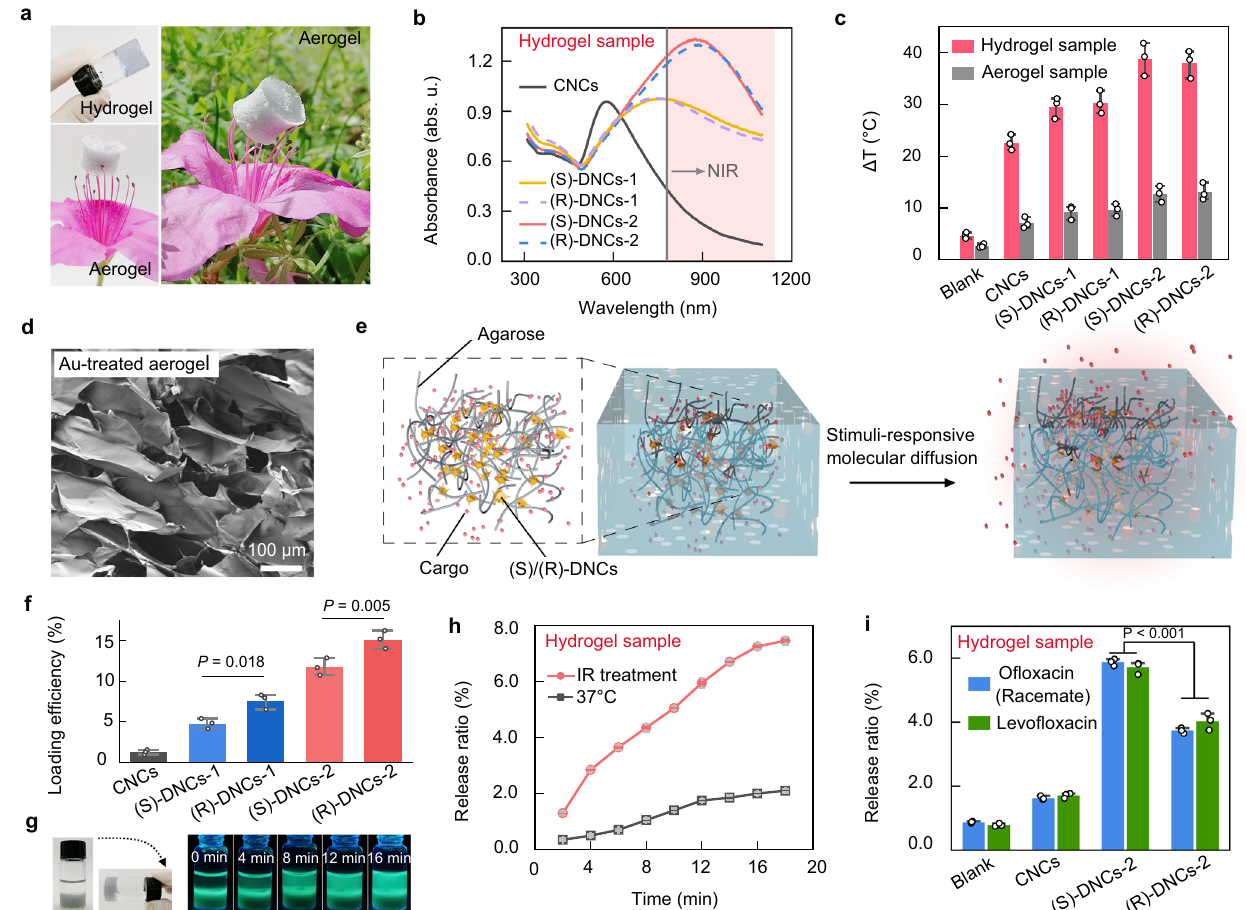
Fig. 5 | IR-responsive drug release properties of hydrogels modi fi ed by chiral dendriticnanocrystals.a Photos ofagarose hydrogels and anaerogeldoped with nanocrystals. b UV-vis-NIRspectrashowingthedifferentopticalabsorptionspectra ofthecrackednanocrystals(CNCs),DNCs-1,andDNCs-2hydrogels. c Temperature changes of aerogels and hydrogels doped with various nanostructures before and after IR (808nm) treatments. d SEM image of the hybrid aerogel (0.8% agarose) after pretreatment with gold spraying. e Schematic illustration showing the com- positionofthehybridhydrogelpackedwithcargoandreleaseofthecargofromthe hybridhydrogelbasedonmoleculardiffusion. f Saturationloadsoflevo fl oxacinfor diverse Au/MoS 2 nanostructures. P <0.05; the signi fi cant difference in the levo- fl oxacinloadingef fi cienciesfor(S)-DNCsand(R)-DNCsnanostructures. g Photosof levo fl oxacin-loaded DNCs-2 hydrogels covered by aqueous solution in the upper layer and UV-irradiated levo fl oxacin-loaded DNCs-2 hydrogels after various times